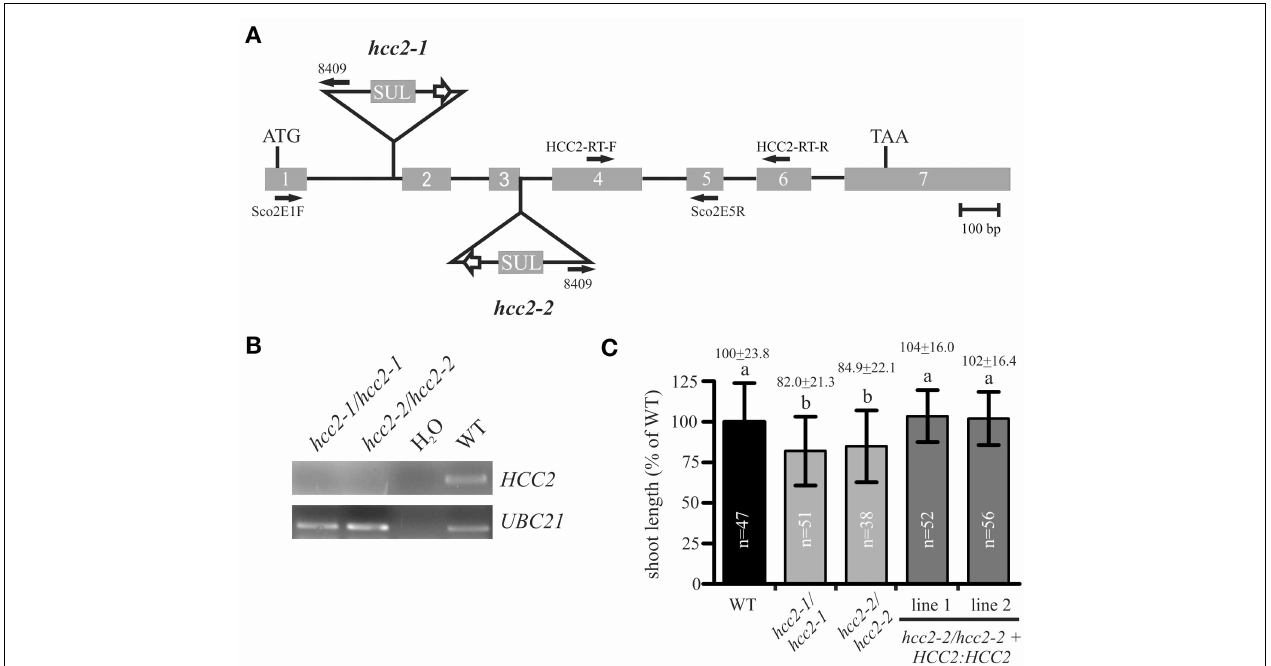
FIGURE 3 | Characterization of hcc2 T-DNA mutants. (A) The schematic diagram of the HCC2 gene shows the insertion sites of T-DNA for the hcc2-1 and hcc2-2 mutant, respectively, the orientation and location of primers (solid arrows), the start (ATG) and stop (TAA) codon. Exons (gray boxes) and introns (solid lines) are drawn to scale. The white arrows denote 35S promoters. SUL, sulfadiazine resistance cassette. (B) RT-PCR analysis of HCC2 expression in homozygous hcc2 mutants and the WT. Water instead of cDNA was used as a